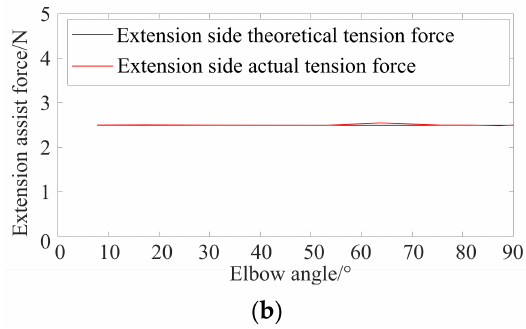
Figure 17. Assist force control experiment of antagonistic cable actuator. ( a ) Flexion side. ( b ) Exten- sion side.